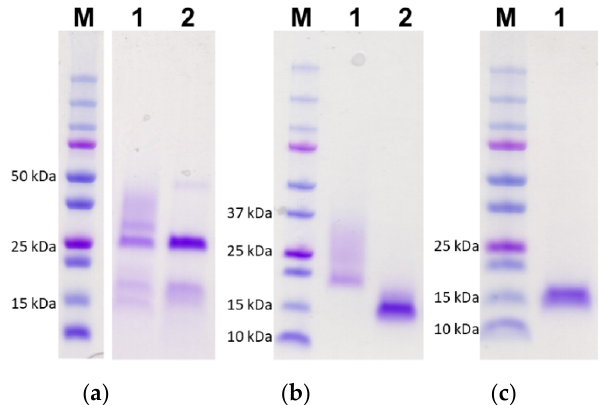
Figure 1. Recombinant expression and purification of rLTB-FhTSP2, rFhTSP2, and rLTB. Yeast culture supernatant for ( a ) rLTB-FhTSP2, ( b ) rFhTSP2, and ( c ) rLTB were each applied to a Ni-NTA column and washed before elution with starter buffer containing 100–400 mM imidazole. A total of 15 µ L of each pooled and concentrated nickel elutions (lane 1) and deglycosylated rLTB-FhTSP2 and rFhTSP2 after incubation with Endoglycosidase H (lane 2) was resolved by SDS-PAGE and stained with Coomassie blue. M, molecular weight markers.